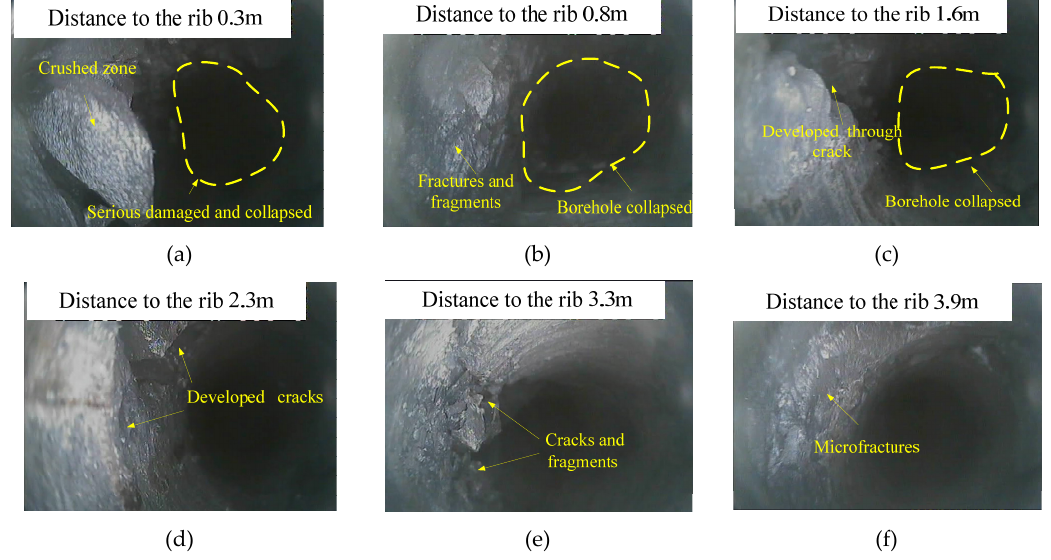
Figure 4. The internal damage of the coal-pillar rib at different depth. ( a ) Distance to the rib 0.3 m; ( b ) distance to the rib 0.8 m; ( c ) distance to the rib 1.6 m; ( d ) distance to the rib 2.3 m; ( e ) distance to the rib 3.3 m; ( f ) distance to the rib 3.9 m.